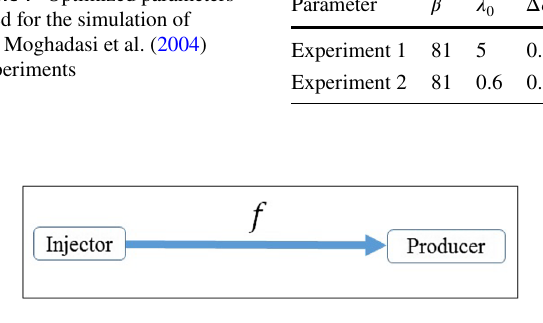
Fig. 3 The schematic of CRMT model in the synthetic case